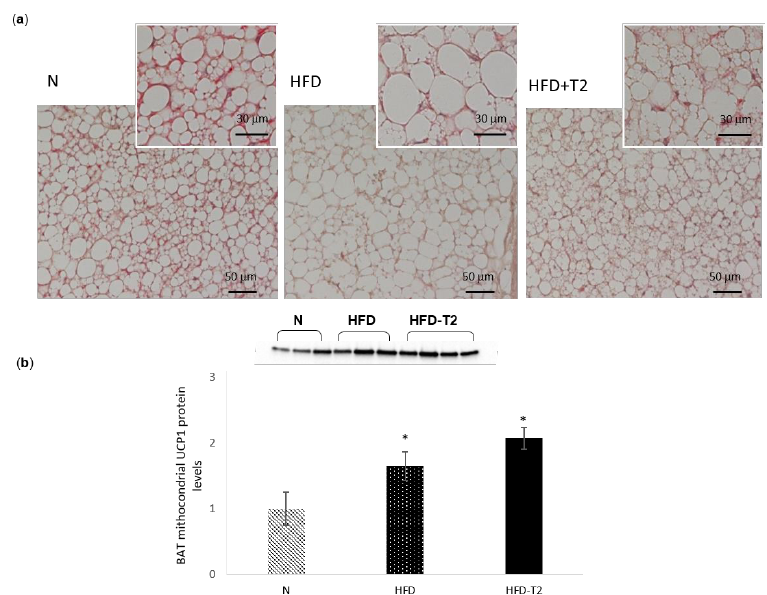
Figure 2. Effects of T 2 administration on BAT morphology and on BAT UCP1 content. ( a ) Representative images (at low magnification-20 × ) showing different cellular organization within BAT parenchyma (haematoxylin and eosin staining). Insets: cellular shapes in the central part of the lobule in BAT parenchyma (40 × ), and ( b ) western blot analysis and quantification of the signals of UCP1 protein levels detected in the whole lysate. For total lysate, each lane contained 15 µ g of protein from a single rat. Values are means ± SEM of five independent experiments ( N = 5), * p < 0.05 vs. N.